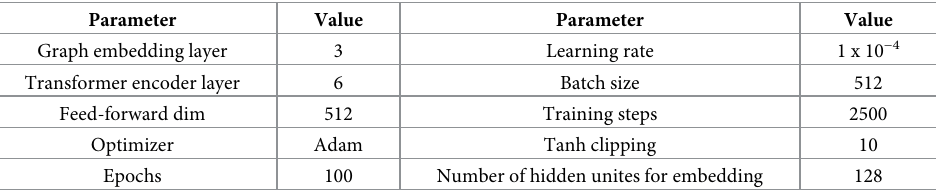
Table 1. Hyperparameters used for training both